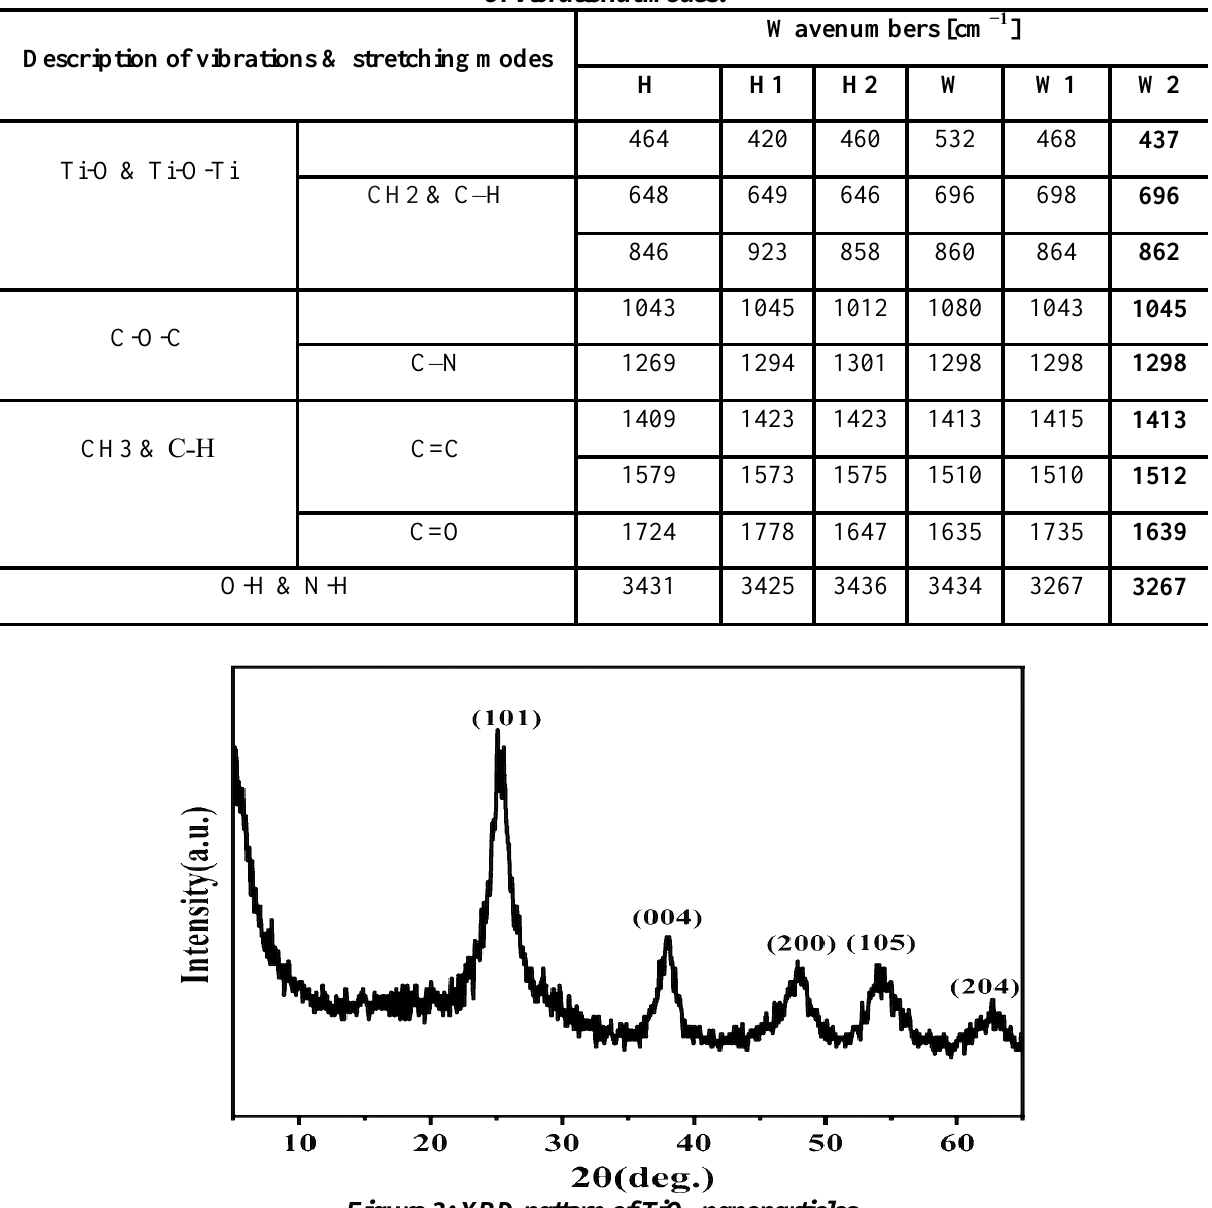
Table 2: Peaks position in the PANITNCs (H, H1, H2, W, W1, and W2) and Assignments of vibrational modes.